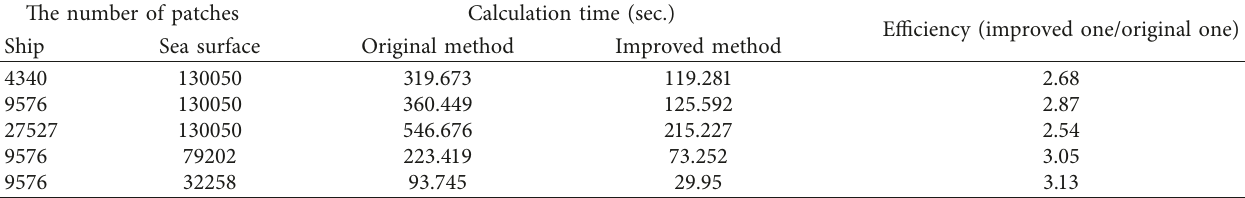
Table 2: Calculation time of the composite scattering of the sea surface and ship for the different methods. The number of patches